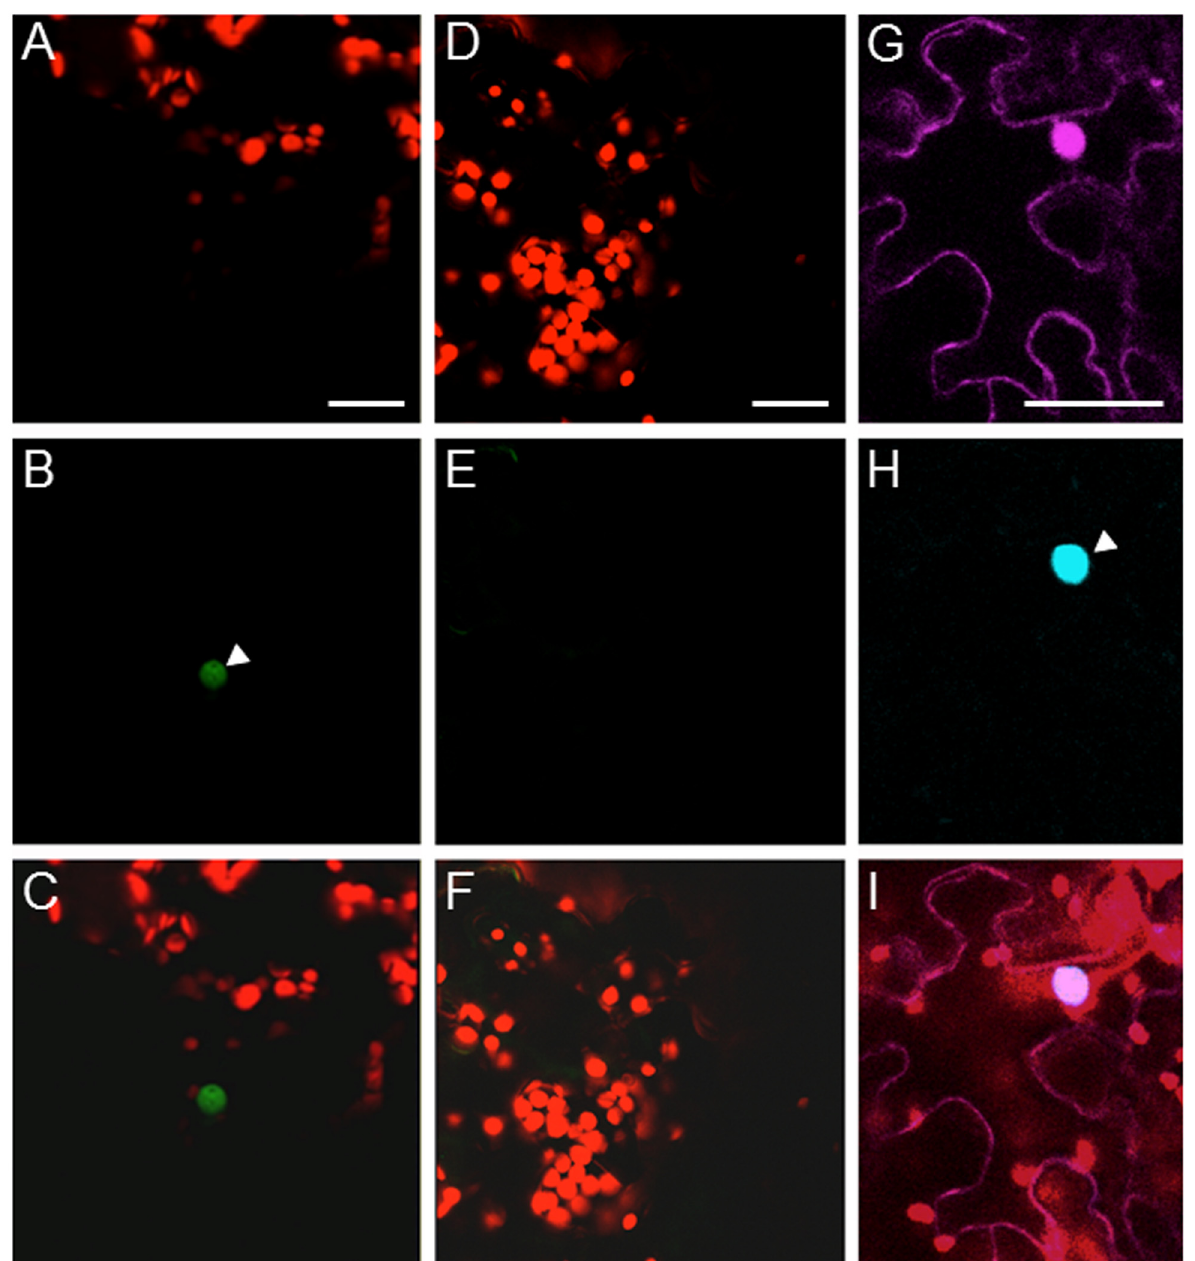
Fig 2. VFP3 interacts with VirF in the cell nucleus. (A-C) BiFC assay for the VFP3-VirF interaction in planta. Constructs encoding nYFP-VFP3 and cYFP-VirF were coexpressed in microbombarded N . benthamiana leaves. (A) Plastid autofluorescence. (B) YFP signal. (C) Merged plastid autofluorescence and YFP signals. (D-F) BiFC assay for the VFP3-VBF interaction in planta. Constructs encoding nYFP-VFP3 and cYFP-VBF were coexpressed in microbombarded N . benthamiana leaves. (D) Plastid autofluorescence. (E) YFP signal. (F) Merged plastid autofluorescence and YFP signals. (G-I) Subcellular localization of CFP-tagged VFP3 coexpressed with free DsRed2 in agroinfiltrated N . benthamiana leaves. (G) DsRed2 signal. (H) CFP signal. (I) Merged plastid autofluorescence, DsRed2 and CFP signals. Location of the cell nucleus is indicated by a white arrowhead. All images are projections of single confocal sections. Scale bars, 20 μ m.